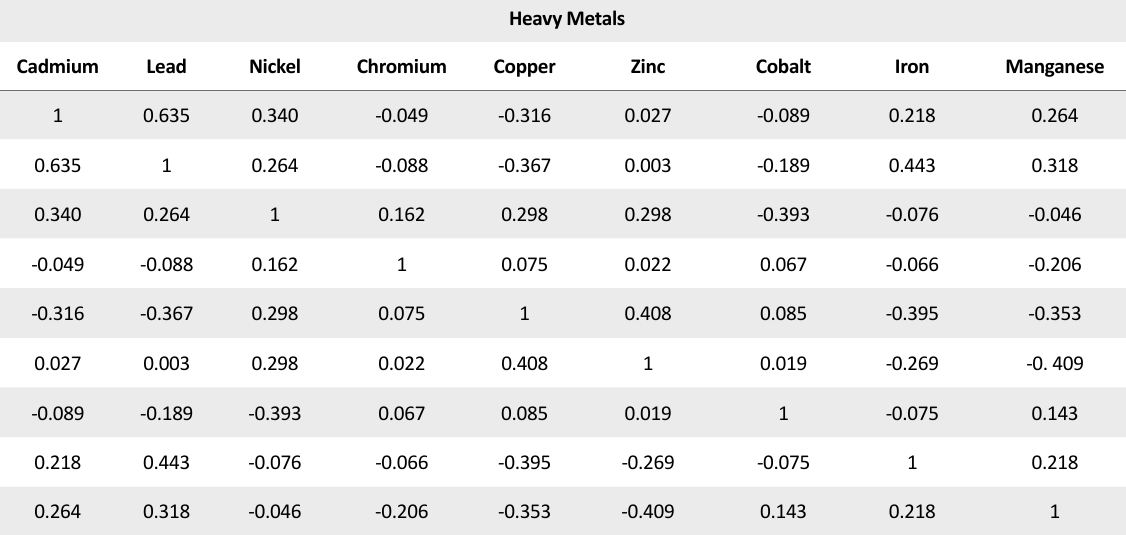
Table 6 . Pearson correlation of heavy metal concentrations in wheat of agricultural fields in Arab Assad region Heavy Metals